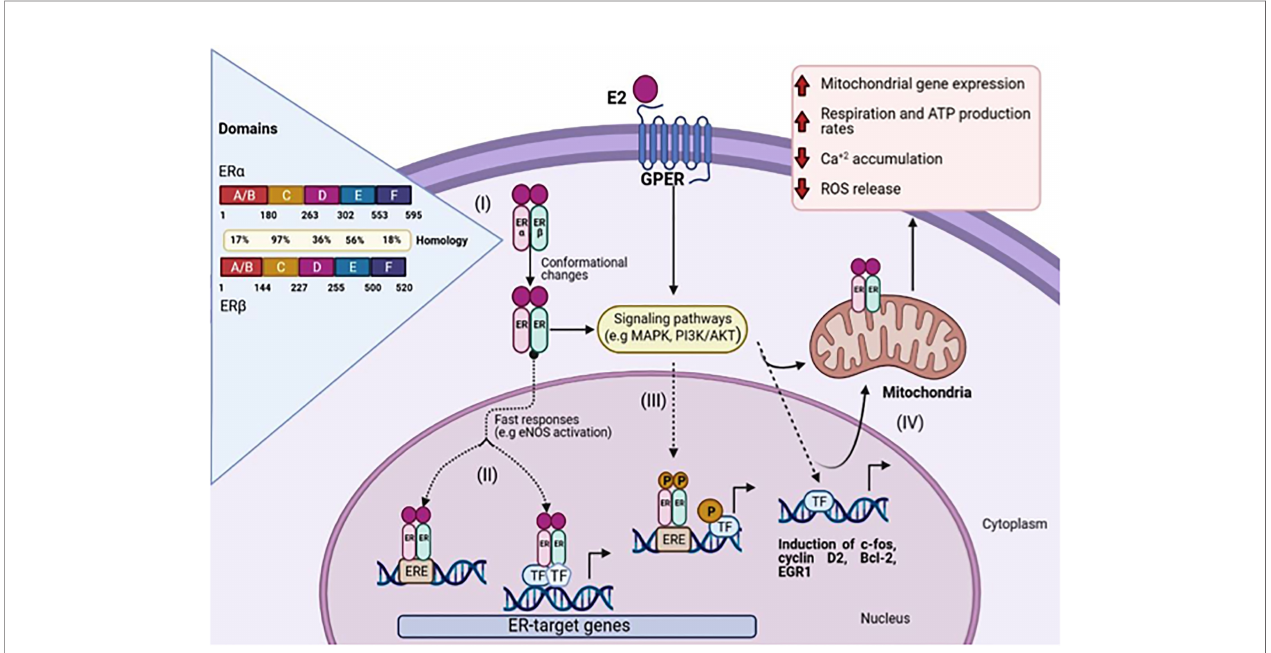
FIGURE 1 | Schematic representation of 17 b -Estradiol induced estrogen receptor- a , b , and GPER signaling. (I) The amino acid sequence position is shown for each domain and the homology between ER a and ER b . Genomic pathway: (II) The E2/ER complex can bind to estrogen response elements (ERE) within the target gene promoter or regulate gene transcription by interacting with other transcription factors (TF), e.g. AP-1 and Sp1. (III) In addition, E2/ER complex activates signaling transduction pathways, leading to phosphorylation of ER or other bound transcription factors modulating gene expression. (IV) E2 initiated cellular and mitochondrial ER/GPER genomic and non-genomic actions modulate mitochondrial respiration, ATP production, and ROS formation. (Figure created with